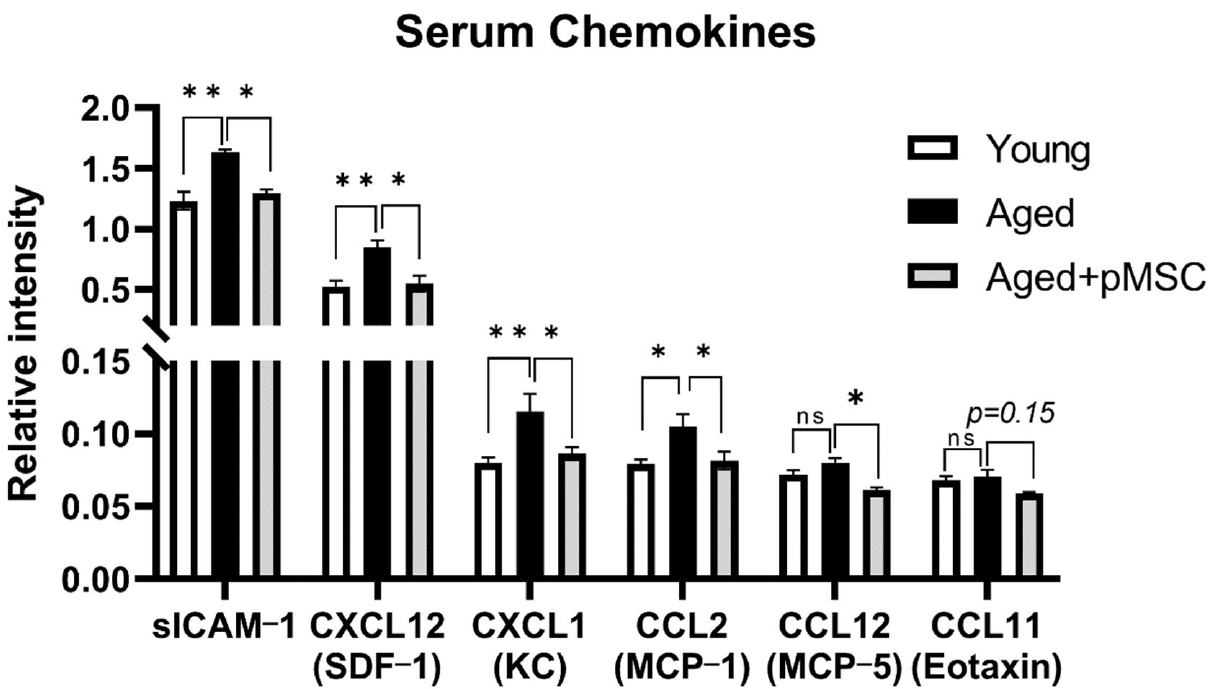
Figure 3. Systemic administration of polarized MSC to aged mice normalizes systemic chemokine levels. Intravenous injection of polarized anti-inflammatory MSC (pMSC, N = 3–4) reduces the levels of plasma chemokines that are associated with aging and inflammation [4] to levels of young (3 months old) mice (N = 7–8) compared with vehicle-treated aged control mice (N = 3), as detected by Proteome Profiler Mouse Cytokine Array (R&D Systems). Bars in the graph present mean ± SE. * p < 0.05, ** p < 0.01. One-way ANOVA. ns = non-significant.